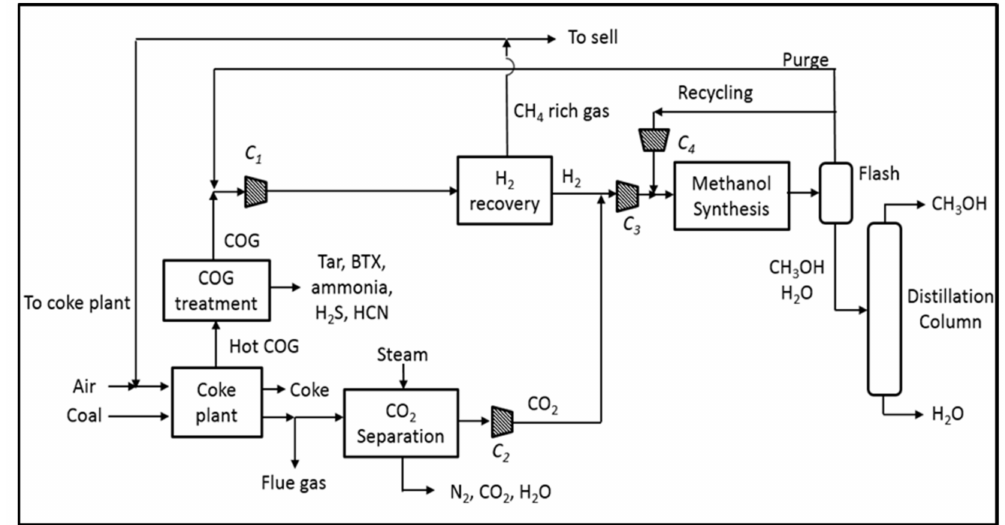
Figure 3. Simplified process flowsheet for the case study A2 (Hydrogen recovery by Pressure Swing Adsorption of